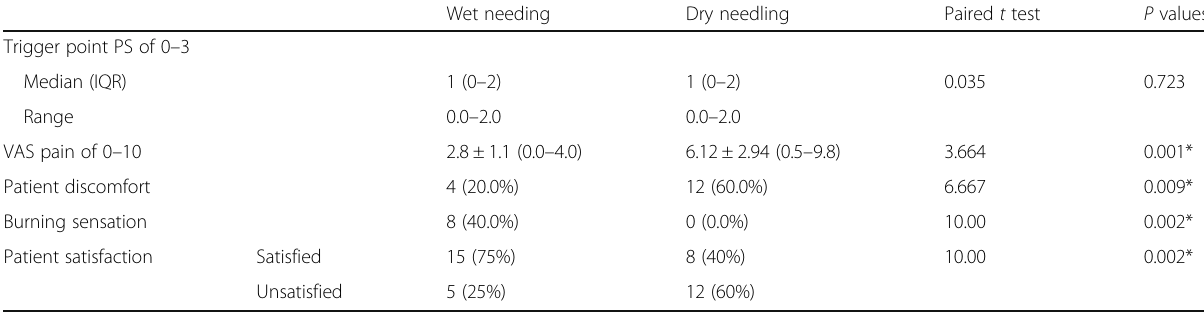
Table 4 Comparing all variables of both groups after treatment Wet needing Dry